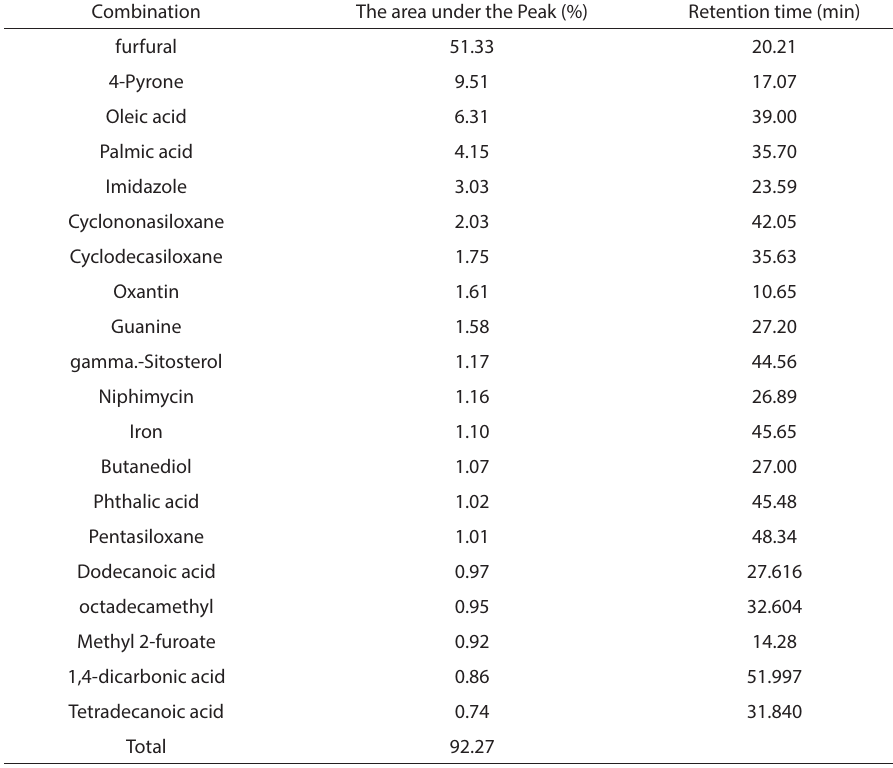
Table 2. Combination Assessment of Jujube Extraction by Gas